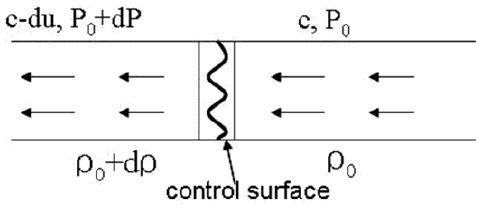
Figure 5. Control volume chosen for analysis.